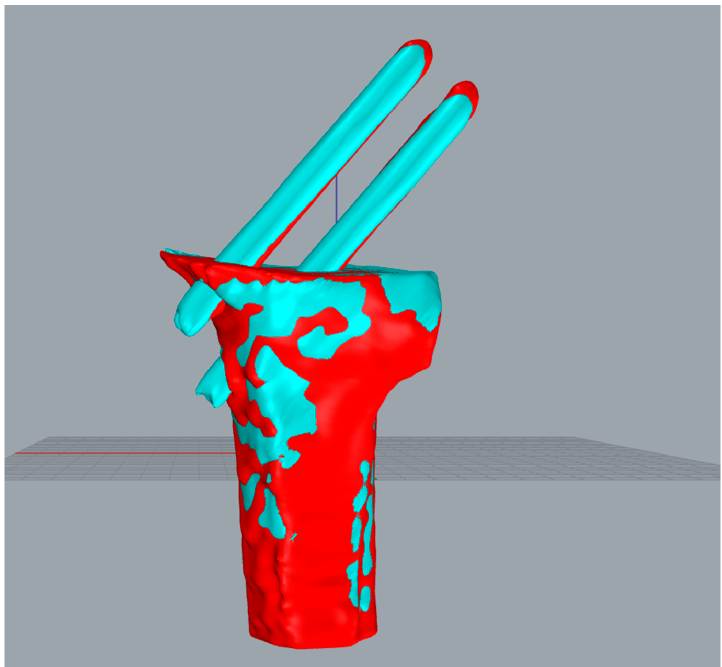
Figure 8. Manually matched and measured displacement of pins.